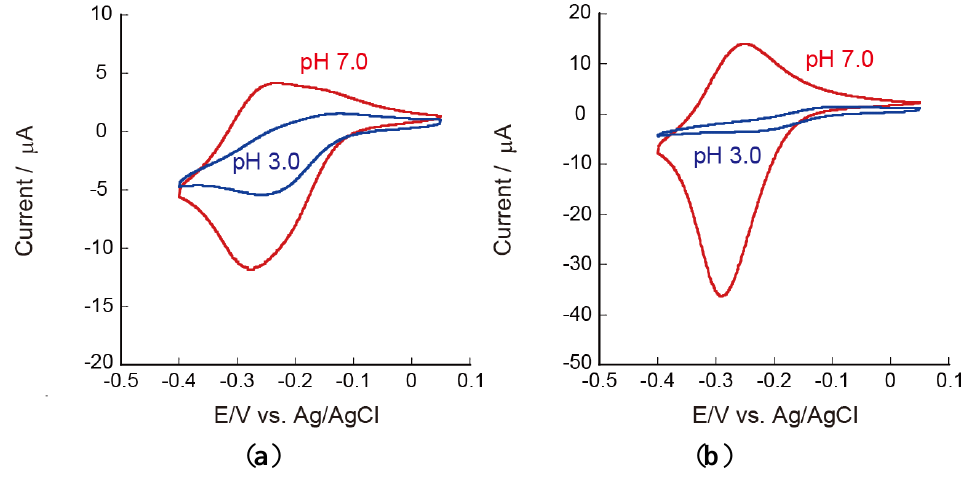
) 63+ on ( a ) PEI(PVS/CHI) 3